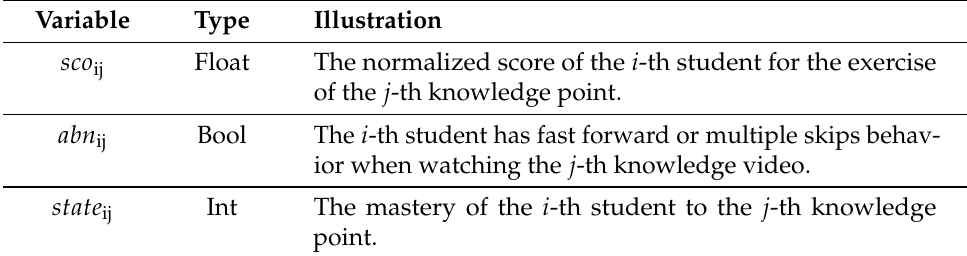
Table 2. Specific parameters of the knowledge mastery model. Variable Type Illustration sco ij Float The normalized score of the i -th student for the exercise of the j -th knowledge point. abn ij Bool The i -th student has fast forward or multiple skips behav- ior when watching the j -th knowledge video. state ij Int The mastery of the i -th student to the j -th knowledge